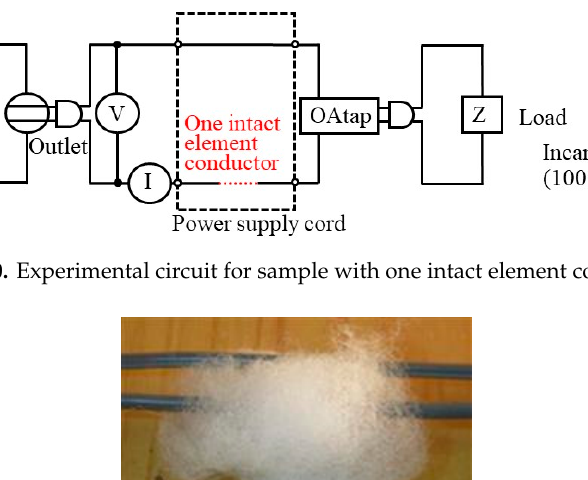
Figure 11. The principal component of the combustibles was dry cotton cut from a cushion: the same material used in the experiments in Chapter II. Energies 2020 , 13 , x FOR PEER REVIEW